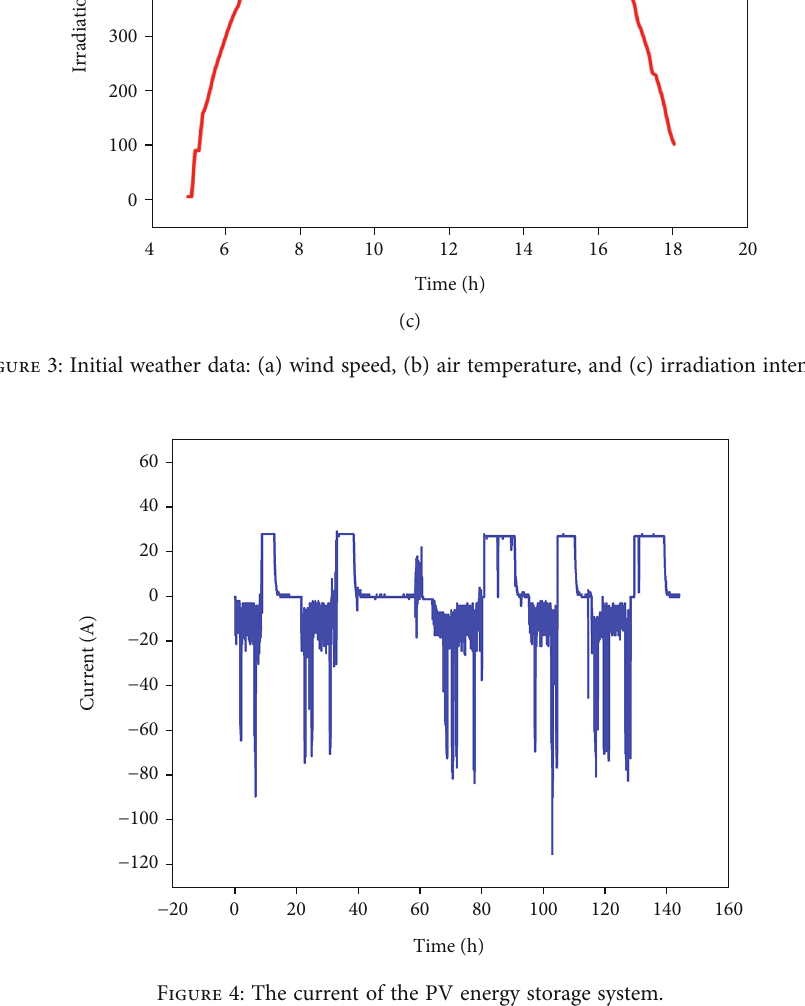
Table 2: Technical parameters of the retired LiFePO